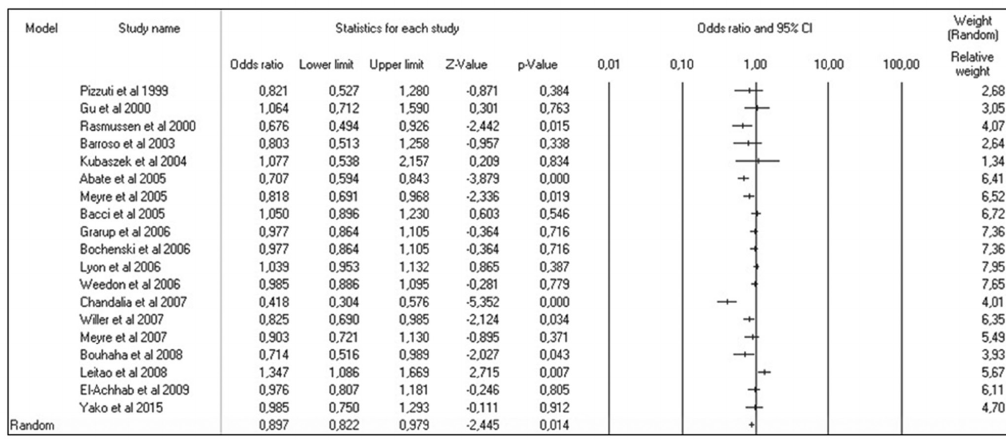
FIGURE 2. Meta‑analysis of the association between the ENPP1 K121Q gene polymorphism and the risk of T2DM (K vs. Q